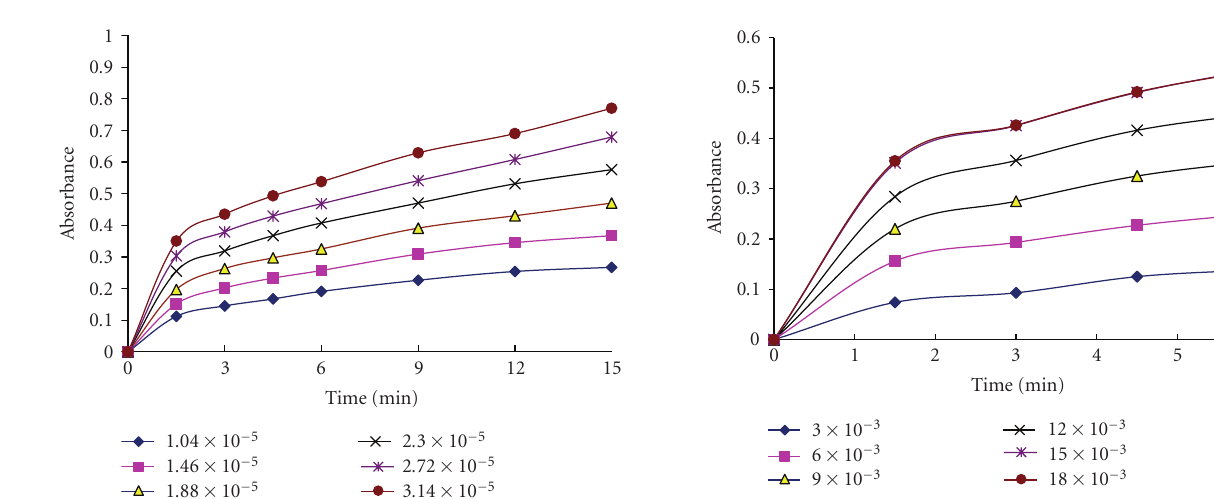
Figure 6: Absorption versus time for the reaction between cefotaxime 3 . 14 × 10 − 5 molL − 1 and KMnO 4 (di ff erent molar